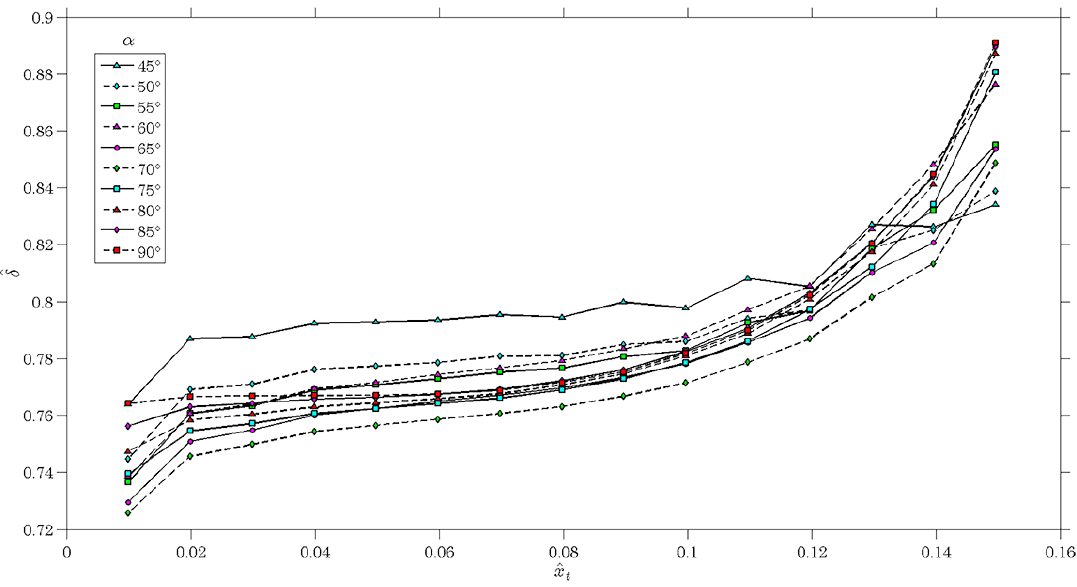
Figure 14. Effects of α on the ˆ δ -angle distributions at the tributary entrance into the confluence at ˆ z ∼